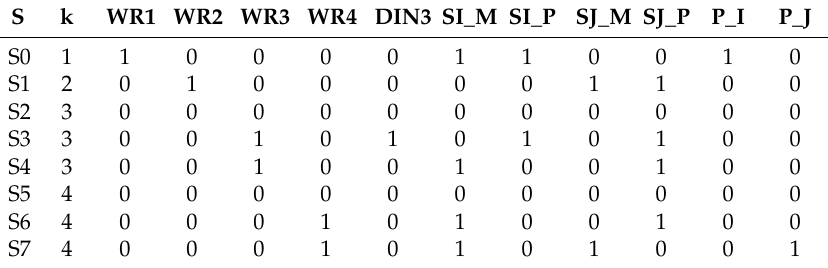
Table 1. The states of the finite-state machine.